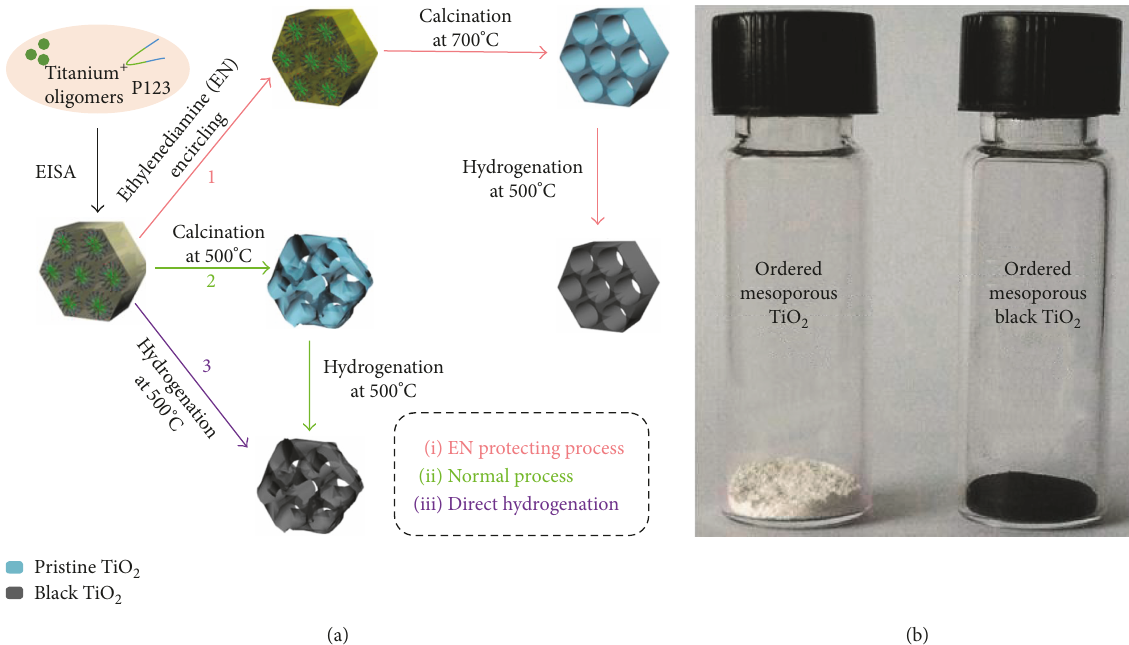
Figure 6: (a) Schematic synthesis process for the ordered mesoporous black TiO after hydrogenation. Reprinted with permission from [78]. Copyright (2014) American Chemical